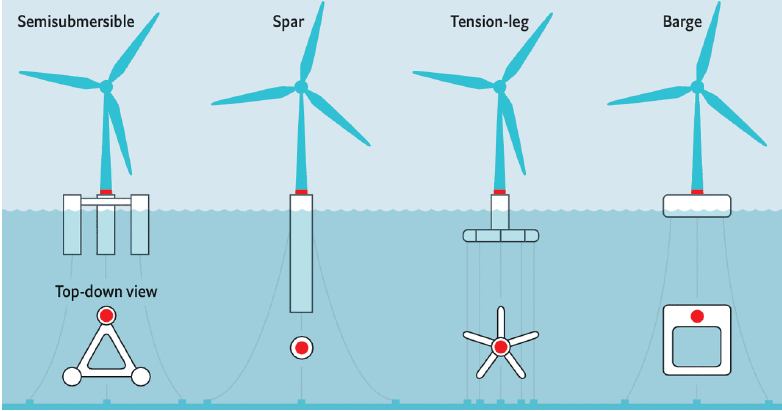
Figure 1. Floating wind platform categories.